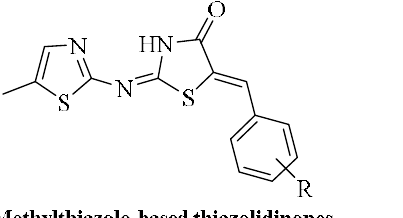
Figure 2. 5-methylthiazole-based thiazolidinones and 5-adamantylthiadiazole-based thiazoli-